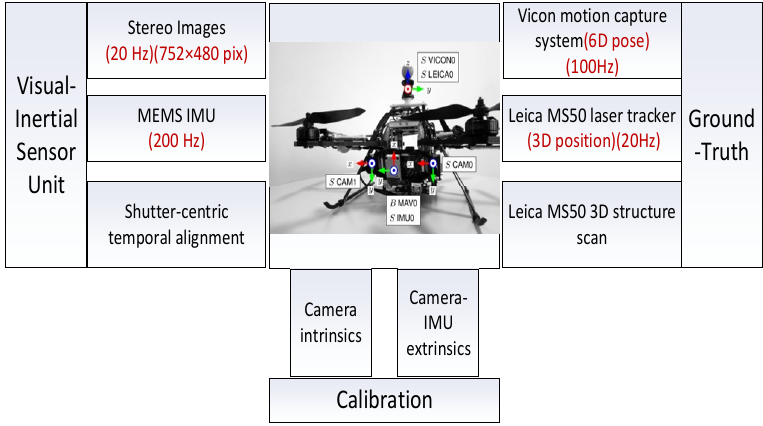
Figure 12. Asctec Firefly drone and sensor configuration parameters.